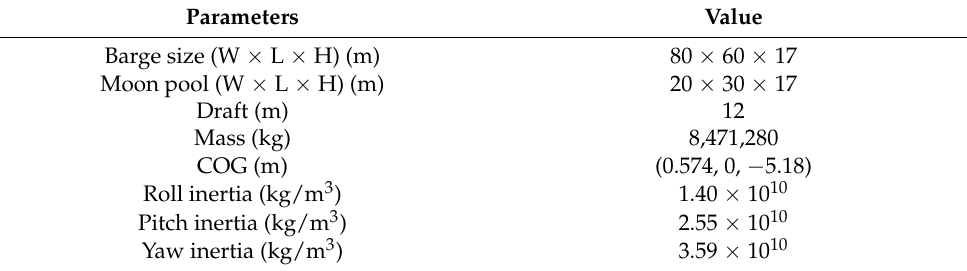
Table 3. Main parameters of the aquaculture cage. Parameters Value Diameter of side column and diagonal column (m) Diameter of diagonal column (m) 2 Thickness of the side column and diagonal column (m) Height (m) 30